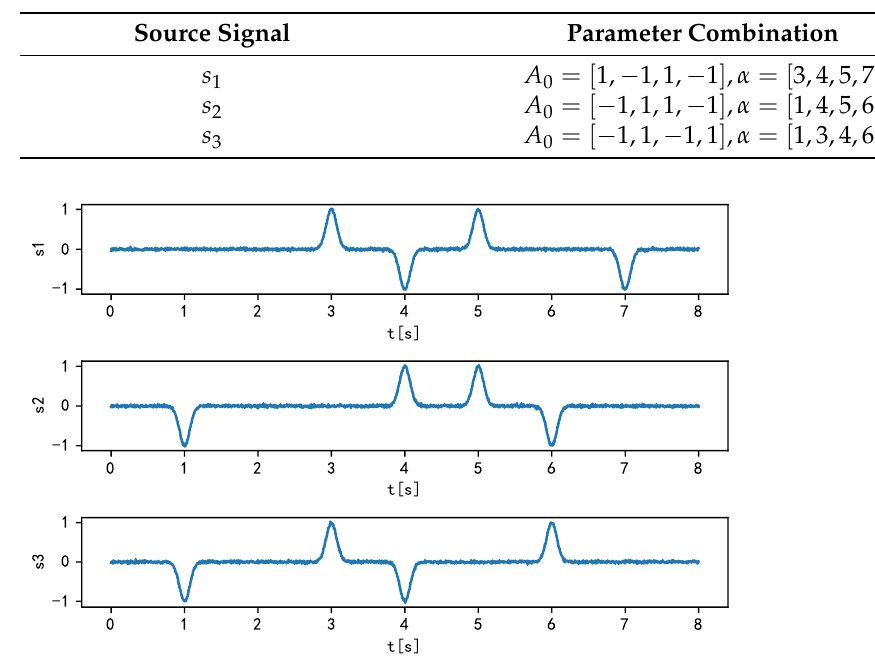
Figure 17. Time-domain waveform of source signal.